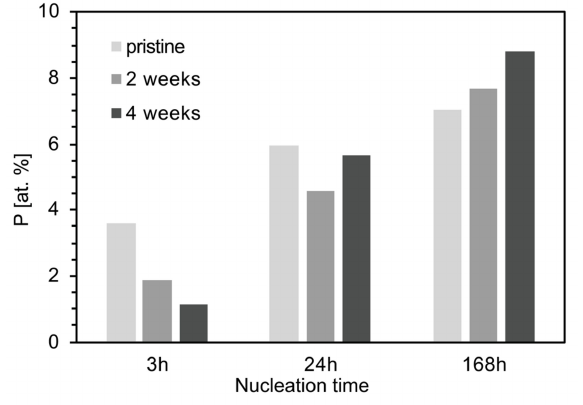
Figure 9. Atomic percentage of phosphorous (measured by EDS) on the surface of foams di ff erently aged after 3 h, 24 h, and 7 days of immersion in